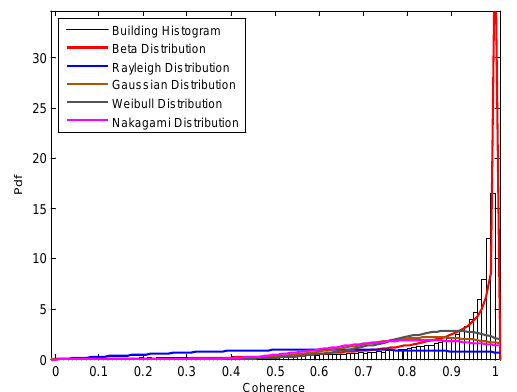
Figure 2. The performances of different statistical models for buildings.